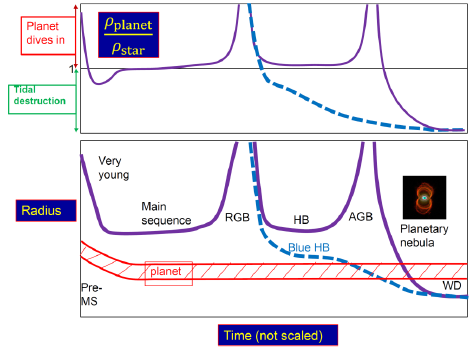
Figure 2. A schematic evolution of the radii and densities of planets and stars from the pre-main- Figure sequence phase to the WD phase. Upper panel : the ratio of the planet density to the stellar density. If